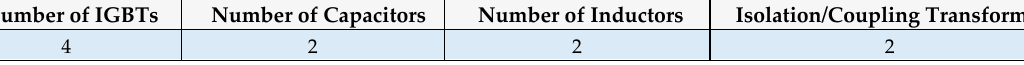
Figure 9. RPC based on a half-bridge two-level converter (HB-RPC) with coupling transformers (based on [27]). Table 7. Components quantities of the HB-RPC.